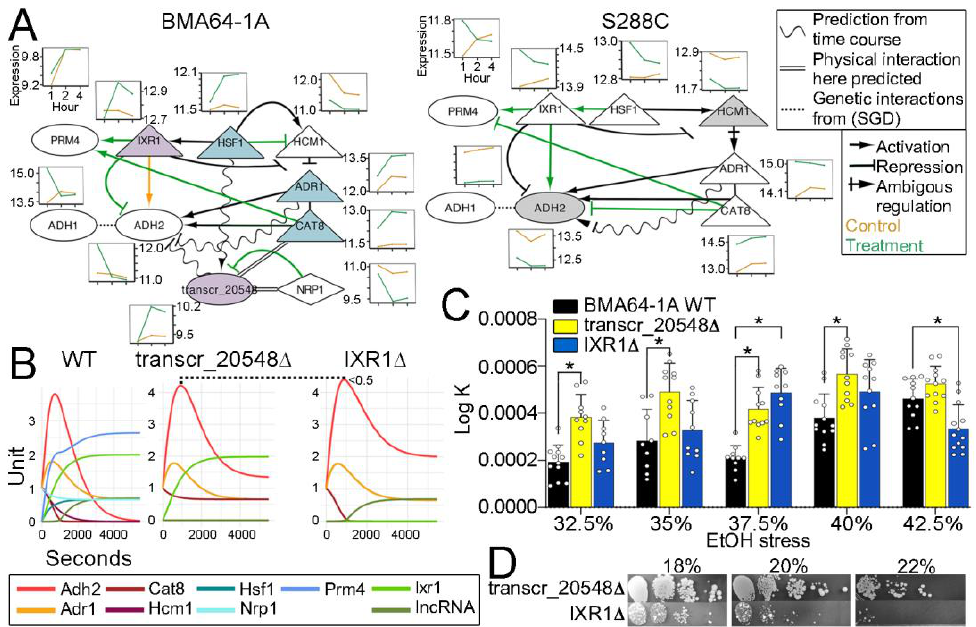
Figure 7. Subsystem model harboring the lncRNA transcr_20548, the diauxic shift, and EtOH stress-buffering genes. ( A ) BMA64-1A and S288C subnetworks. Small boxes represent the time-course data for each gene. Nodes with the same color have a similar time-course profile. These subnetworks were manually curated, including published data, information from the SGD database, and transcriptome time-course data from BMA64-1A and S288C. ( B ) BMA64-1A subnetwork dynamic network simulations of ordinary differential equations based on the transcriptome time-course of treatment conditions that simulate gene expression in virtual BMA64-1A WT and mutants. ( C ) Population rebound after stress relief in WT and BMA64-1A CRISPR–Cas9 mutants. * indicates a p value < 0.01. ( D ) EtOH tolerance spot test.